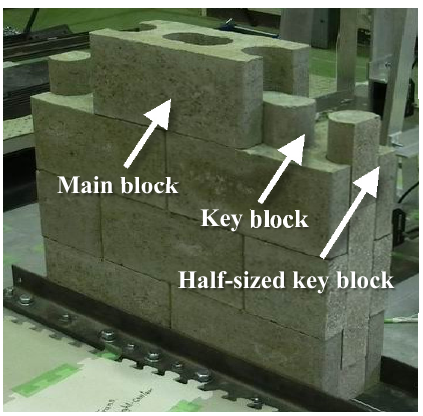
Figure 5. Construction of the peanuts-shaped concrete block wall specimen.